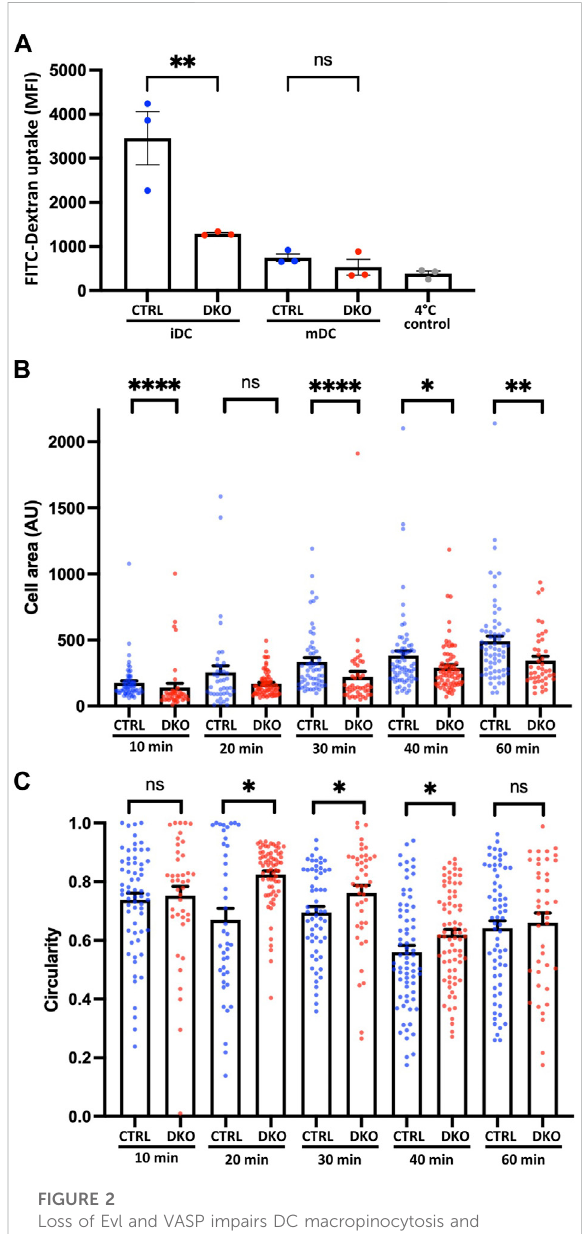
FIGURE 2 Loss of Evl and VASP impairs DC macropinocytosis and spreading. (A) Evl/VASP DKO iDCs show impaired macropinocytosis. Immature and mature control and DKO DCs were incubated with FITC-dextran for 1 h at 37 ° C. FITC- dextran uptake was quanti fi ed by fl ow cytometry. In grey: control cells left at 4 ° C to reveal background binding. Mean fl uorescence intensity (MFI) depicted as mean ± SEM (N=3 independent experiments, statistical analysis by One-Way-ANOVA followed by Tukey post-test; ** p < 0.01; ns=non signi fi cant). (B,C) Mature control and DKO DCs were allowed to spread on fi bronectin- coated cover slips for the indicated time points. Cells were processed for immuno fl uorescence and incubated with phalloidin to stain F-actin and thus visualize cell shape. Cell area (B; in arbitrary units, AU) and circularity (C) were quanti fi ed based on ImageJ (depicted as mean ± SEM; statistical analysis by Mann- Whitney test; N = 41-74 cells from 3 independent cultures processed in 2 independent experiments; * p < 0.05; ** p < 0.01; *** p < 0.001; **** p < 0.0001; ns = non signi fi